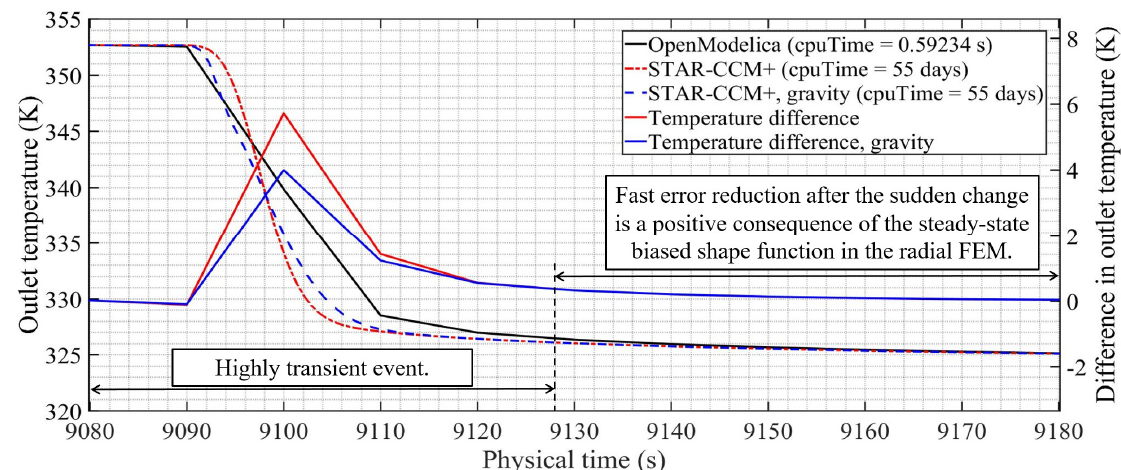
Figure 26. Detail of the difference in temperature on comparison with a model from STAR-CCM+.